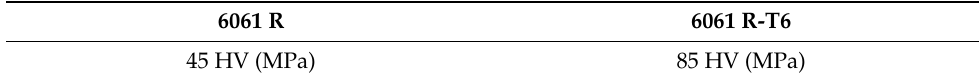
Table 2. Hardness measured for each recycled aluminum alloy.